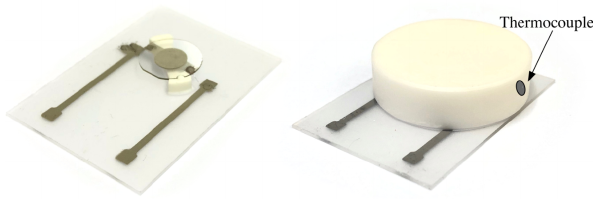
Figure 2. CTGS resonator with two connectors screen-printed on a sapphire surface without (left) and with (right) the top cap made from polycrystalline alumina. The gray point is marking the posi- tion where an additional thermocouple type S subsequently is at-